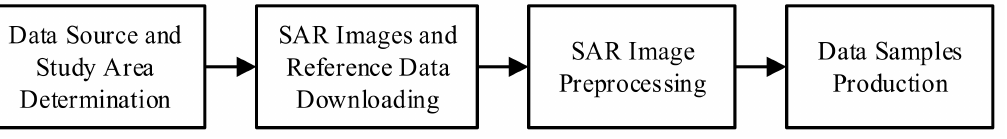
Figure 1. Dataset construction